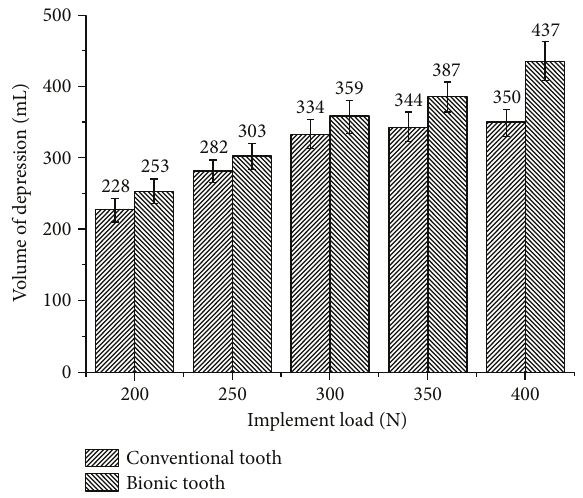
Figure 13: Test result volume of depression created by conventional and bionic toothed